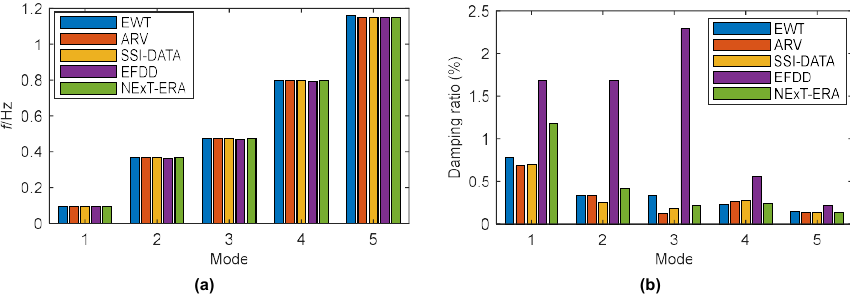
Figure 12. Comparison of modal parameters for Canton Tower identified by EWT, ARV, SSI-DATA,